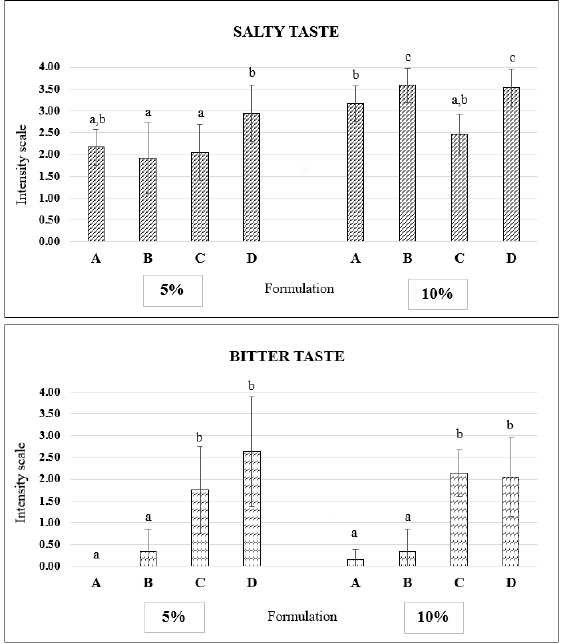
Figure 3. Sensory properties of smoked mackerel formulations. The results are presented as mean values ± SD. Formulations: A—100% NaCl, B—75% NaCl + 25% KCl, C—50% NaCl + 50% KCl and D—25% NaCl + 75% KCl. Different superscript letters indicate significant differences among formu- lations ( p < 0.05). Sensory attributes were assessed using a 5-point intensity scale, where 0—absent, 1—slight, 2—moderate (adequate for salty taste), 3—strong and 4—extreme.